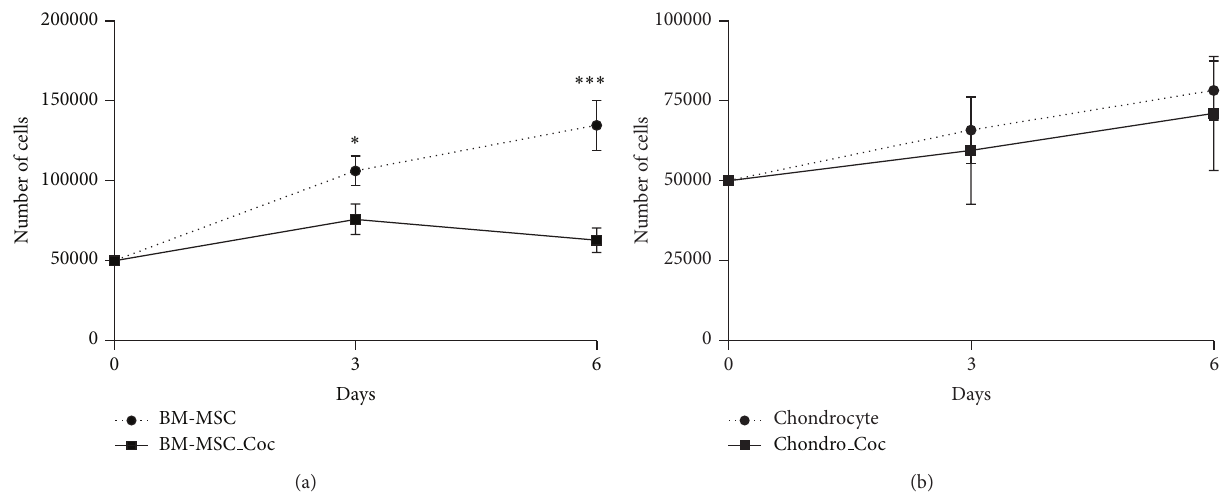
Figure 1: BM-MSCs decrease cell number after coculture with OA-chondrocytes. Number of cells cultivated for 3 and 6 days in monoculture ( 𝑛 = 6 ; bone marrow mesenchymal stem cells (BM-MSCs) and chondrocytes) or in coculture ( 𝑛 = 6 ; BM-MSC Coc and Chondro Coc). Error bars represent the SEM for the mean value. Statistical significance (two-way ANOVA) is set according to the number of asterisks, as follows: ∗ 𝑃 ≤ 0.05 , ∗∗∗ 𝑃 ≤ 0.0001 .